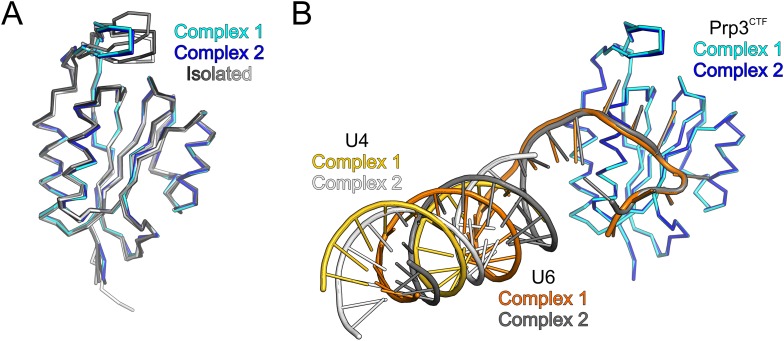
Structural comparisons.(A) Ribbon plots of all crystallographically independent, superimposed structures of the yPrp3 DUF1115 domain. Isolated yPrp3DUF1115—white; isolated yPrp3CTF—gray colors; RNA-bound yPrp3CTF—cyan and blue. (B)Structural superimposition of the two crystallographically independent yPrp3CTF-yU4/U6stemII+10nt complexes based on the protein portions. yPrp3296−469—cyan (complex 1) and blue (comply 2); yU4—gold (complex 1) and light gray (complex 2); yU6—orange (complex 1) and dark gray (complex 2).